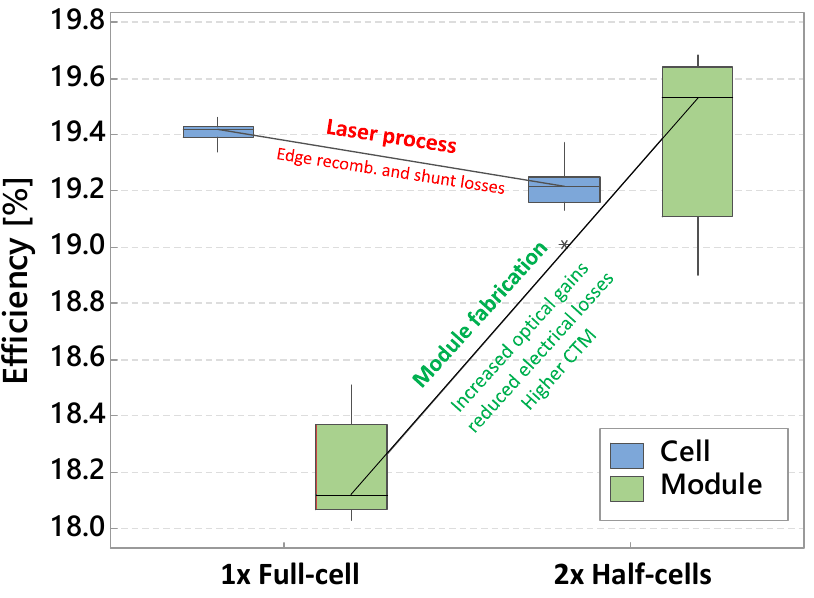
Figure 4. Efficiency loss due to laser process after separation of single cells into two half cells and overcompensation of losses at the module level fabricated from the same solar cells due to reduced electrical losses and increased optical gains (adapted from [46]).